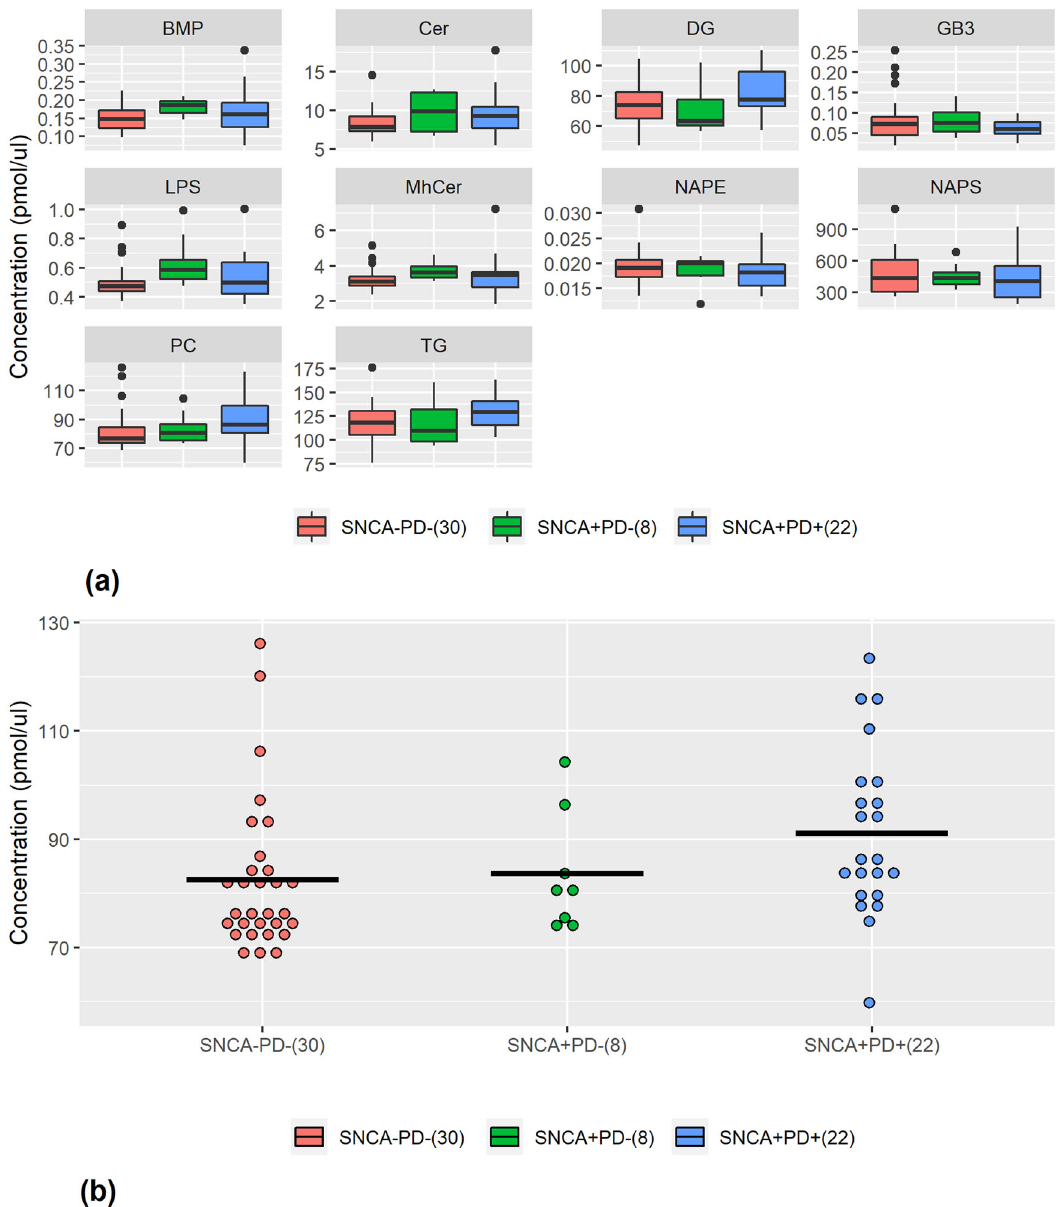
Fig. 1 Serum concentrations of the ten most in fl uential lipid classes. Lipid acronyms: PC glycerophosphatidylcholine, NAPS N -acyl phosphatidylserine, DG diradylglycerol, GB3 globotriaosylceramide, Cer ceramide, MhCer monohexosylceramide, BMP bis(monoacylglycero) phosphate, LPS lysophosphatidylserine, TG triradylglycerol, NAPE N -acylphosphatidylethanolamine. a Serum concentrations for the most in fl uential classes as identi fi ed by RF (Table 1). The center line represents the median, the bounds of the box are 25th percentile (Q1) and 75th percentile (Q3), the whiskers are Q1 − 1.5*IQR and Q3 + 1.5*IQR, and the dots are outliers. b Linear increase in glycerophosphatidylcholine (PC) concentration from SNCA − /PD − through SNCA + /PD − to SNCA + /PD + . Note that subjects of the SNCA + /PD − group were not part of the analysis and are shown here only for comparison with the other two groups of subjects. Black lines represent groups ’ means. Numbers of observations in